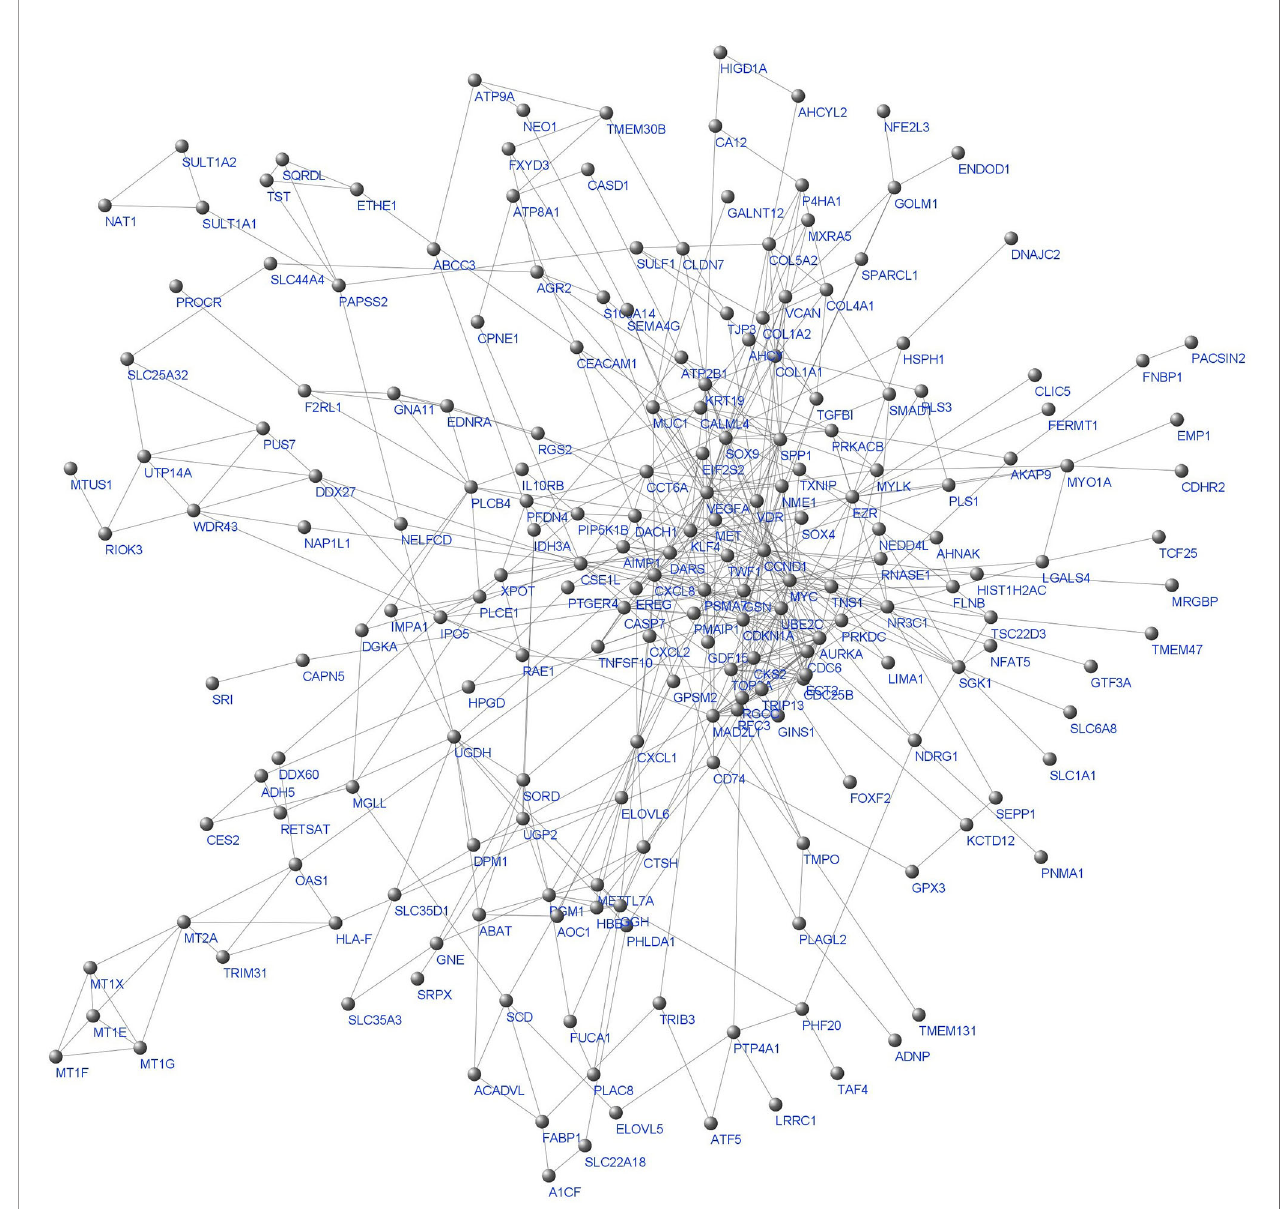
FIGURE 3 | The whole network giant component. Labels are protein/gene symbols. This is a scale free network (46) which follows a power law distribution (most of the network nodes have a low degree while there are few nodes with high